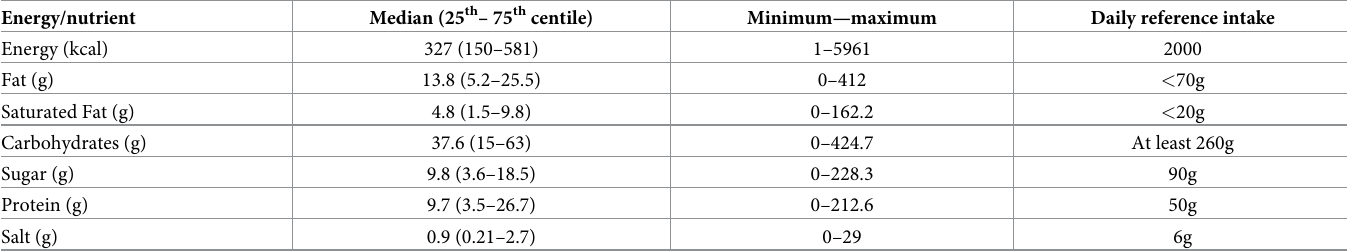
Table 4. Distribution of energy and nutrients in 9605 menu items from 42 popular UK chain